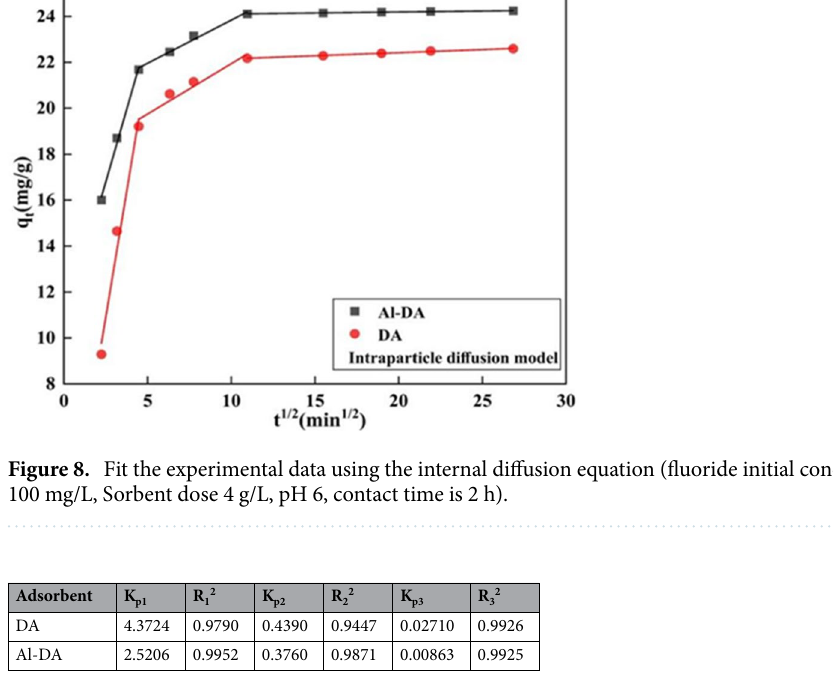
Table 3. Internal diffusion model fitting results.